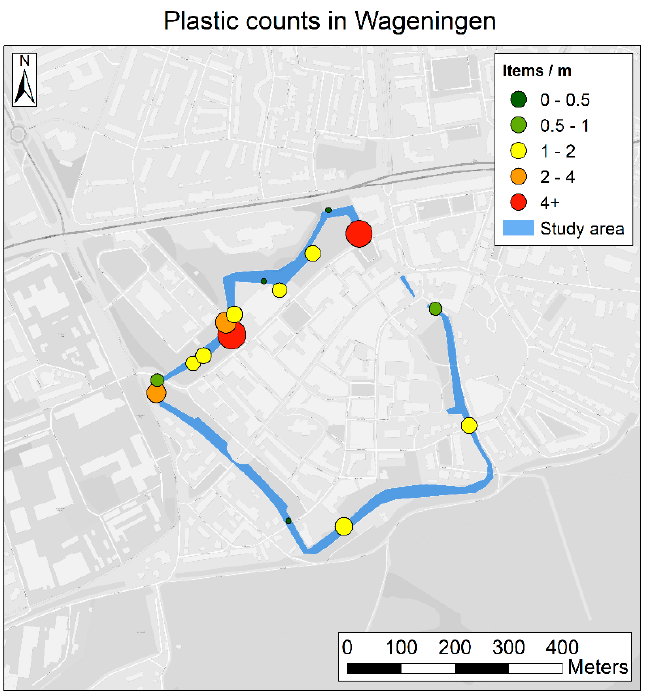
Figure 5. Plastic item density in the Wageningen urban water system, 5 March 2020.